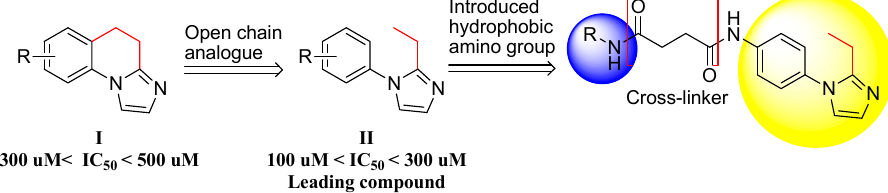
Figure 2. Title compounds design. Yellow: pharmacophore and Blue: aliphatic/aromatic amine.